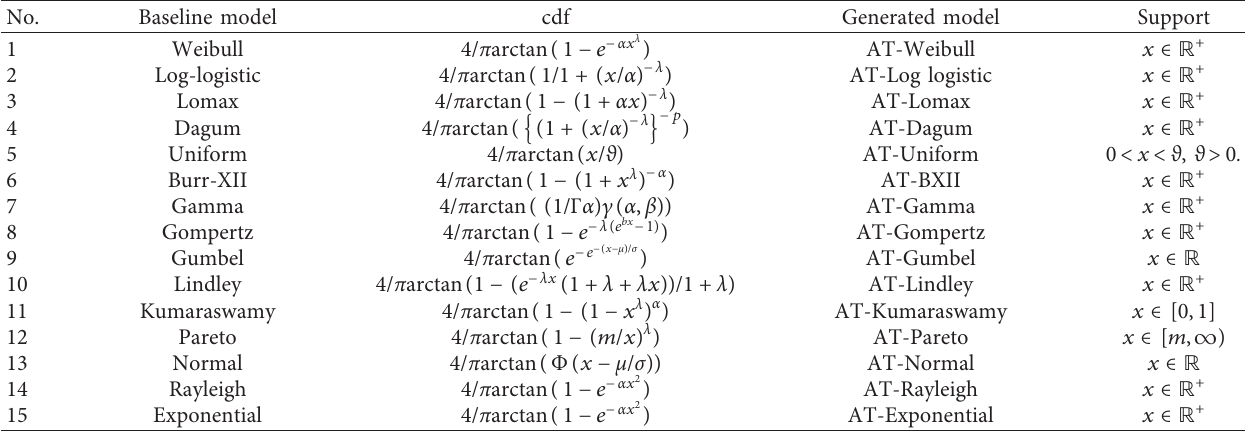
Table 1: New contributed special cases of the Arctan-X